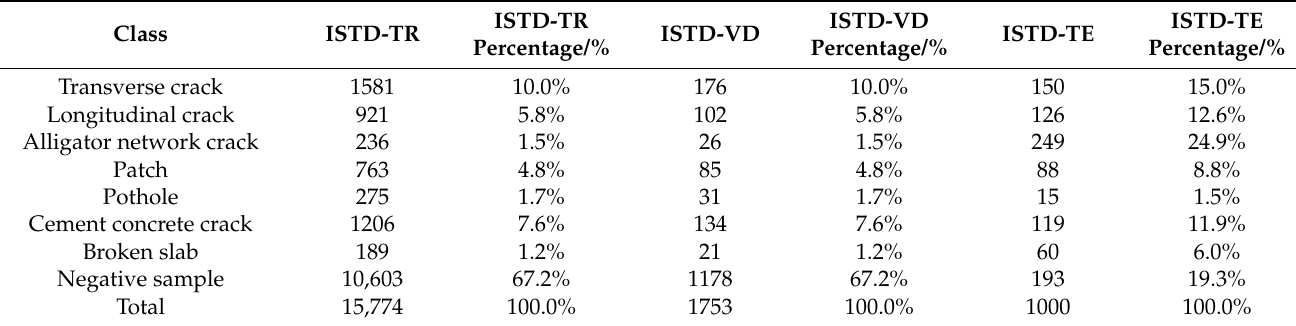
Table 3. Dataset splitting of